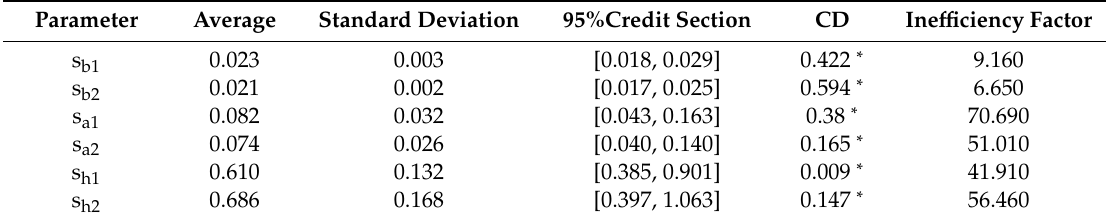
Table 5. Estimation results of the TVP-VAR model parameters on the CNY ( E1 t ,PL t , PJ t ) . Parameter Average